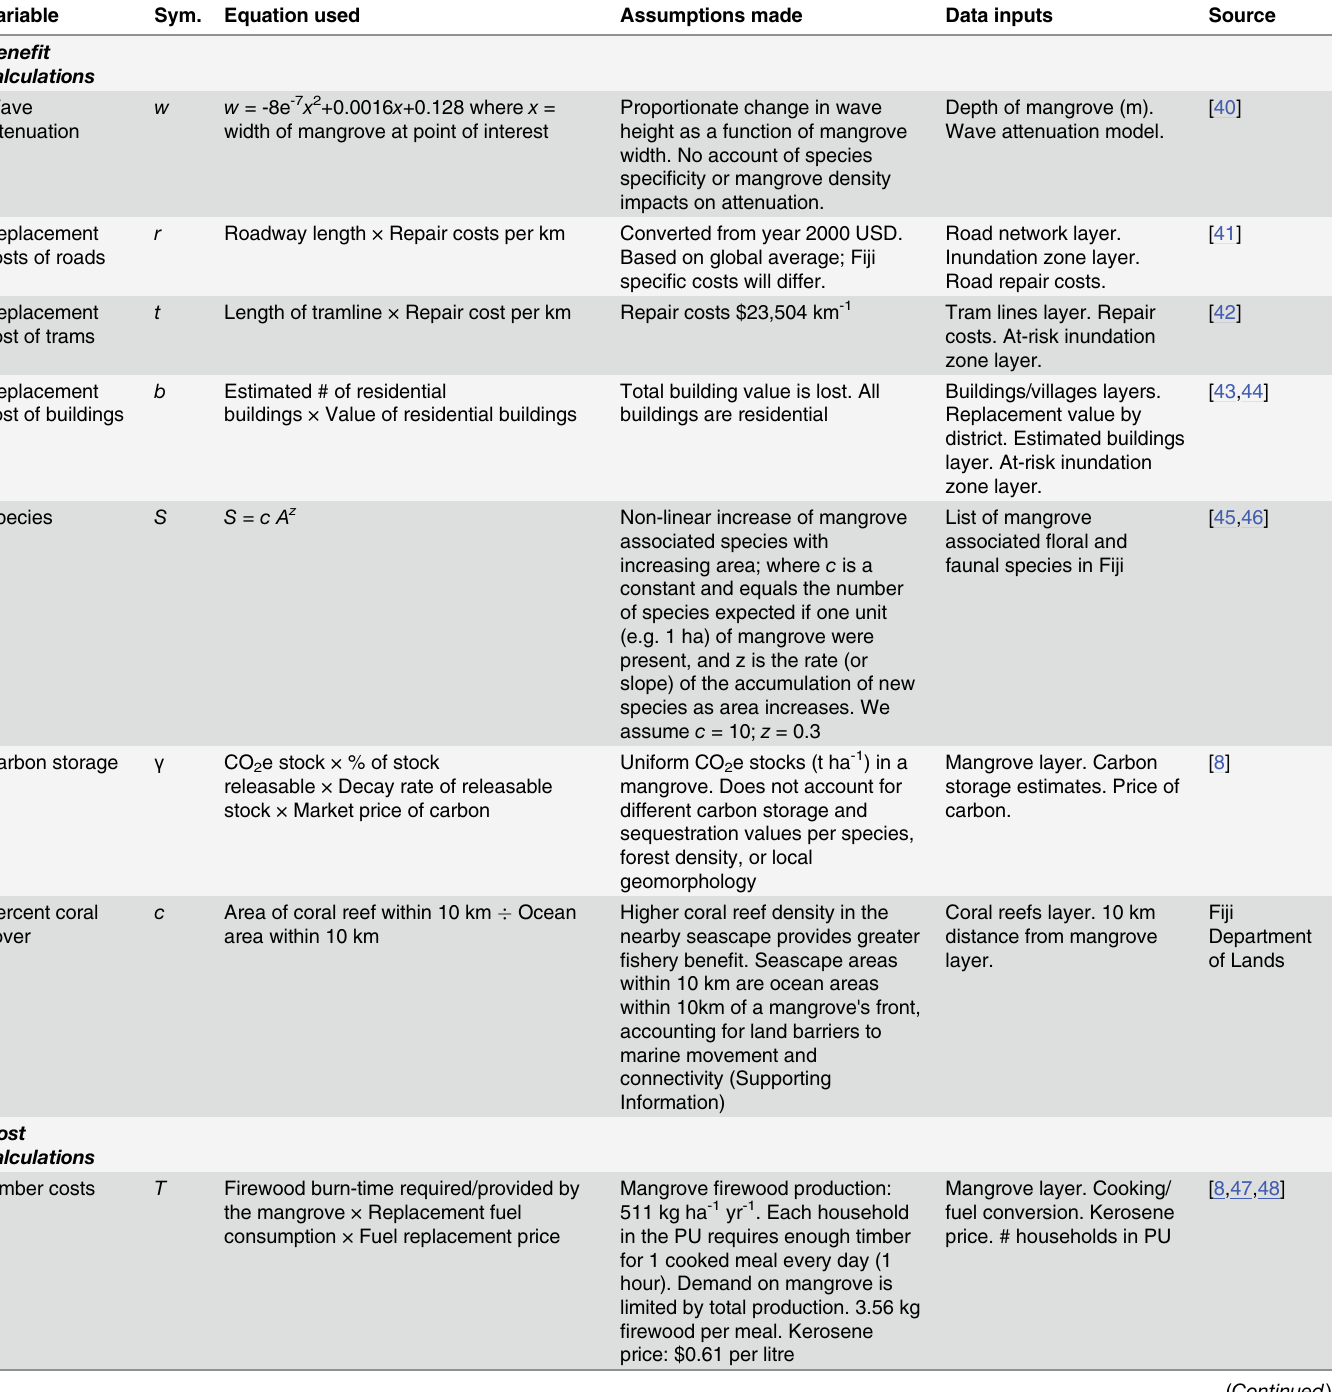
Table 1. Parameters used in calculation of costs and benefits for four mangrove ecosystem